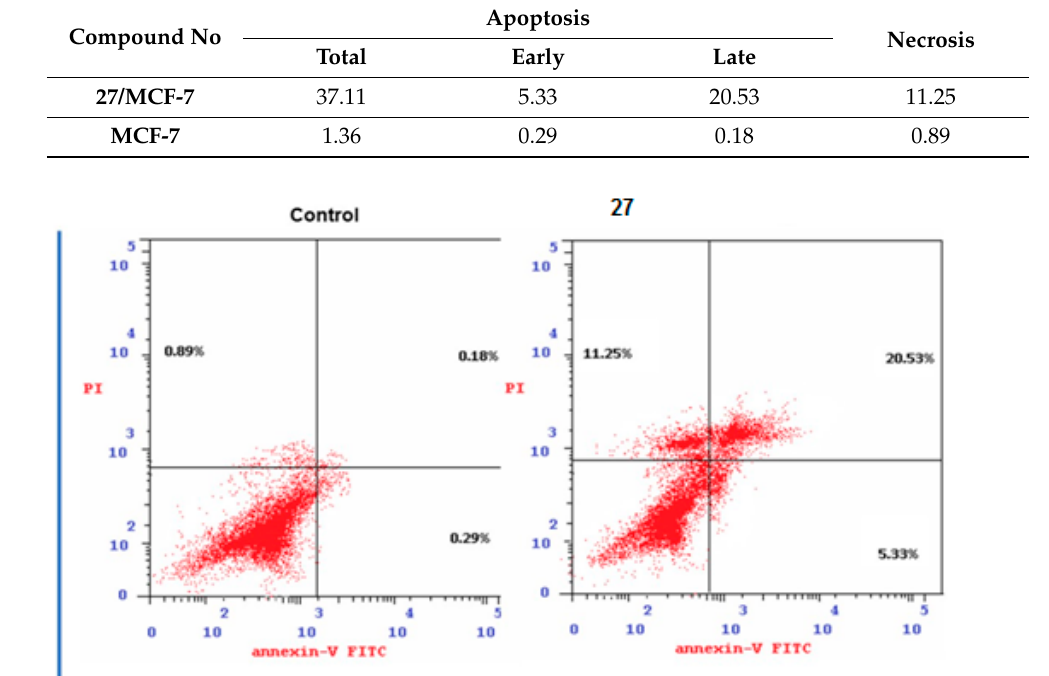
Table 4. Apoptotic activity of compound 27 .